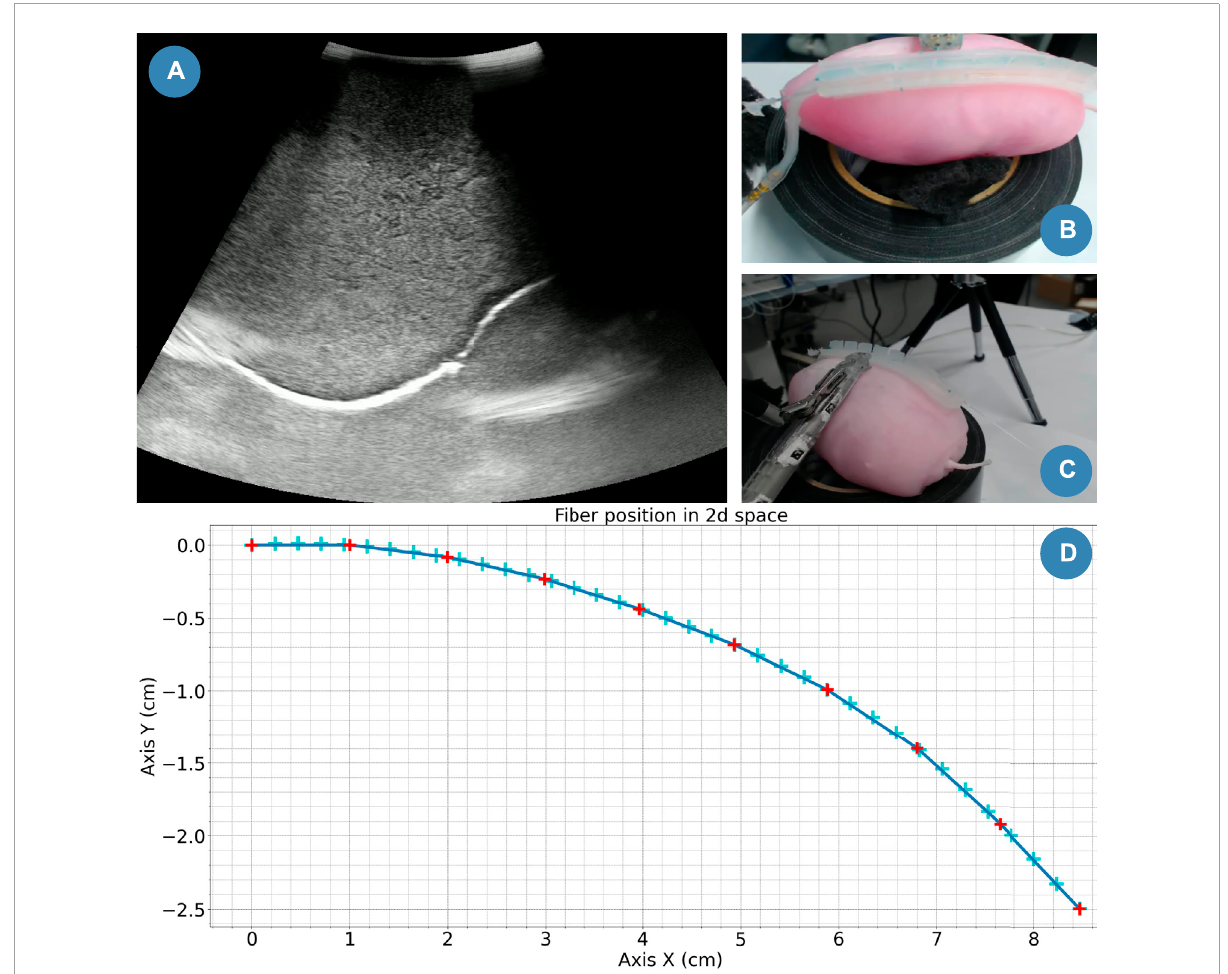
FIGURE 11 Case study snapshot. (A) Stream snapshot recorded with the drop-in US probe. (B) Camera top view. (C) Camera lateral view. (D) Computed drop-in US